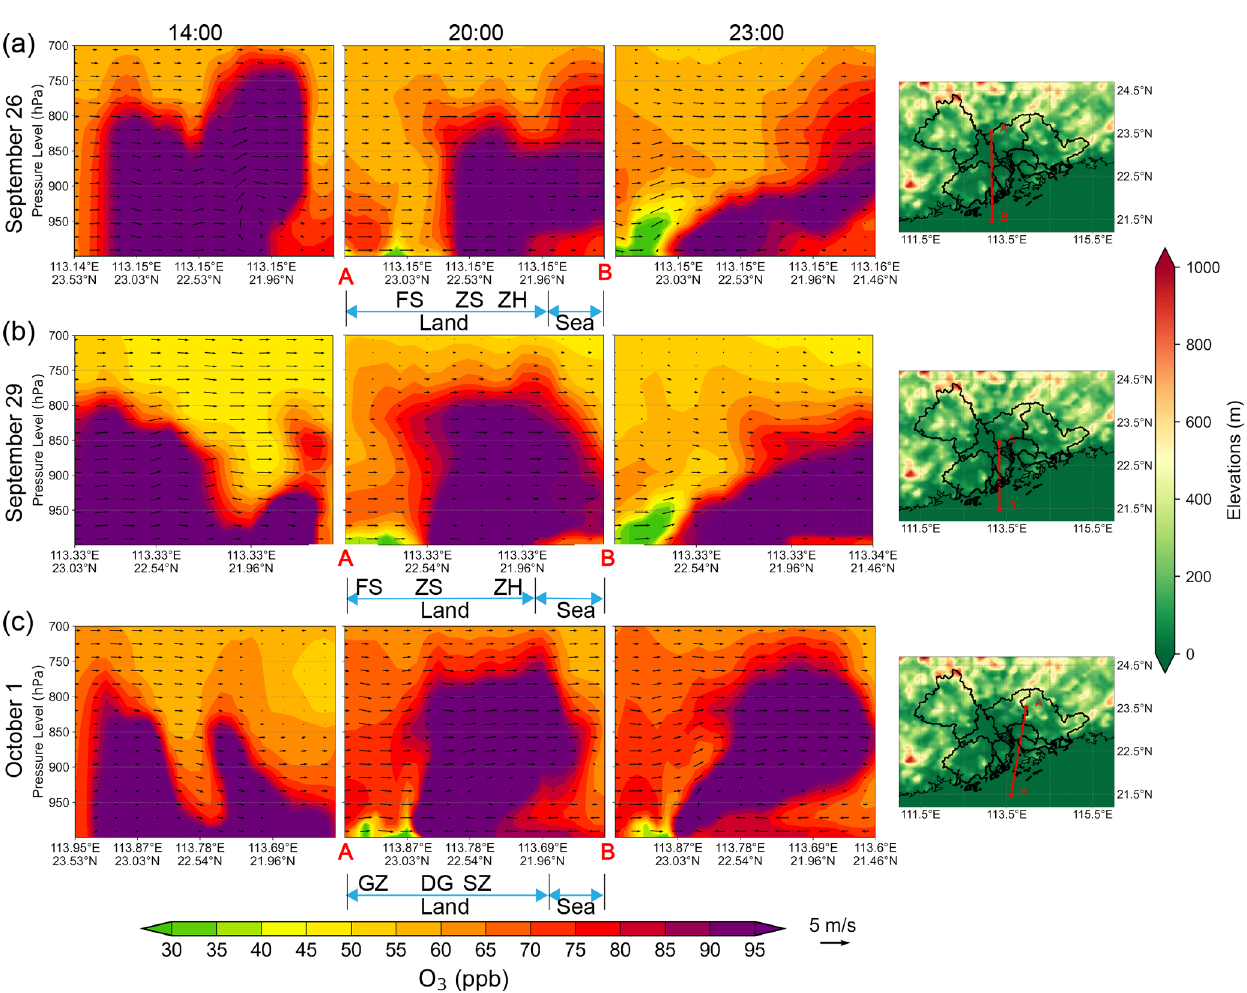
Figure 8. Vertical distribution of O 3 concentration (contours) and atmospheric circulation (wind vectors) over PRD along the WD 10 at 14:00, 20:00, and 23:00 on (a) 26 September, (b) 29 September, and (c) 1